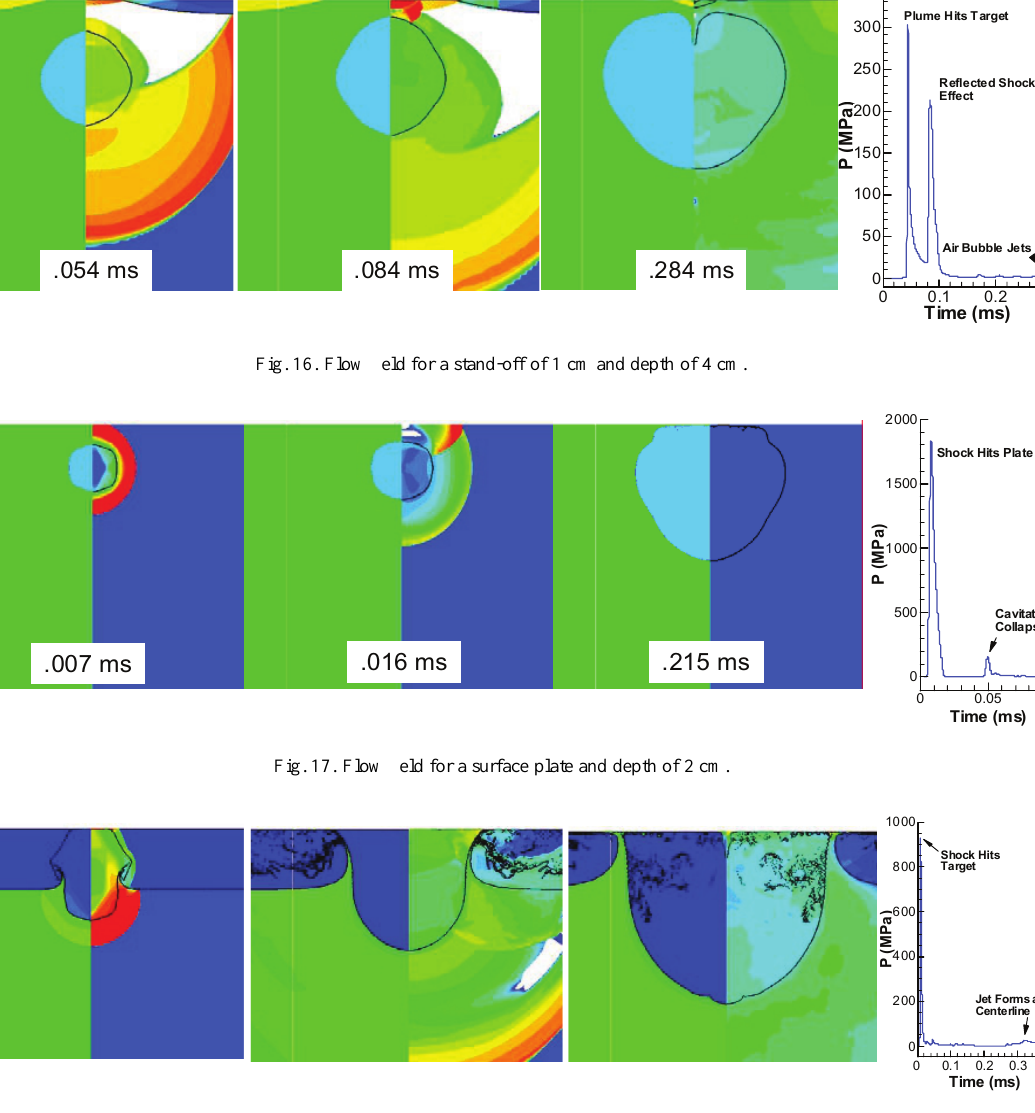
Fig. 18. Flow field for a surface charge and plate stand-off of 4